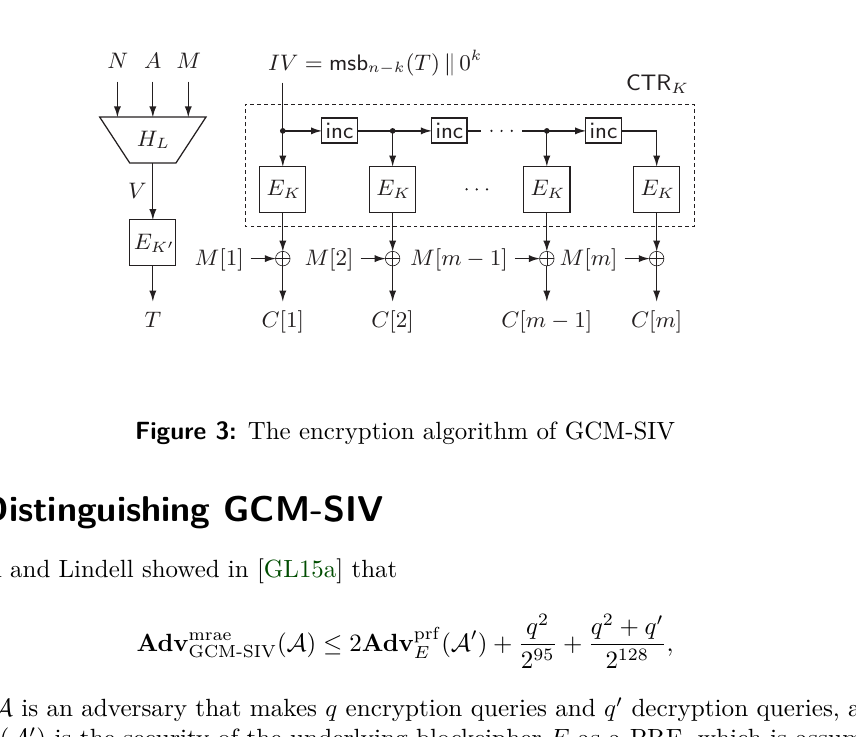
Figure 2: Definitions of GHASH L ( A, M ) and CTR K ( IV, m )